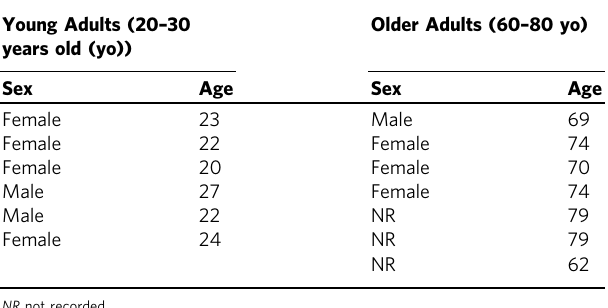
Table 1 Human PBMC donor